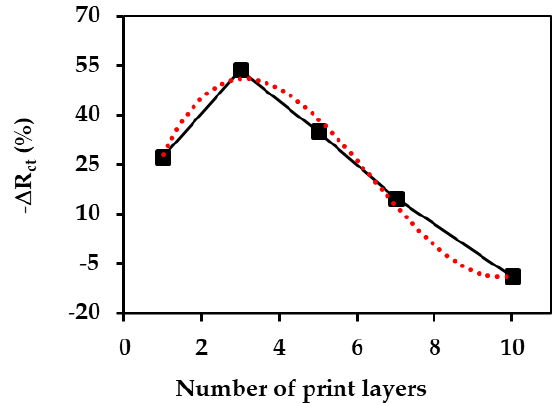
The limit of detection (LOD) can be calculated by the following equation [42]: